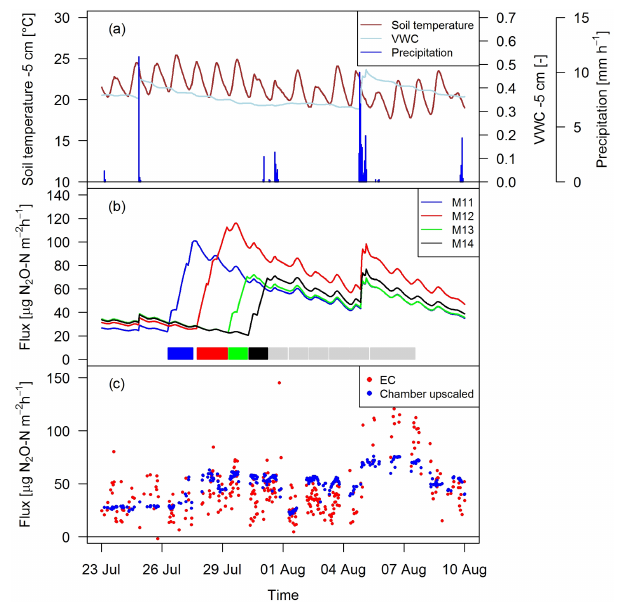
Figure 10. Time series of (a) environmental parameters and (b) up- scaled FB fluxes (Sect. 2.7) for different paddocks (M11–M14) in system M. The colored rectangles at the bottom show the graz- ing phases on the four considered paddocks (grey colors indicating grazing on the remaining paddocks). (c) N 2 O fluxes by EC and up- scaled FB during a full rotation between 23 September and 10 Au- gust 2016 for system M.